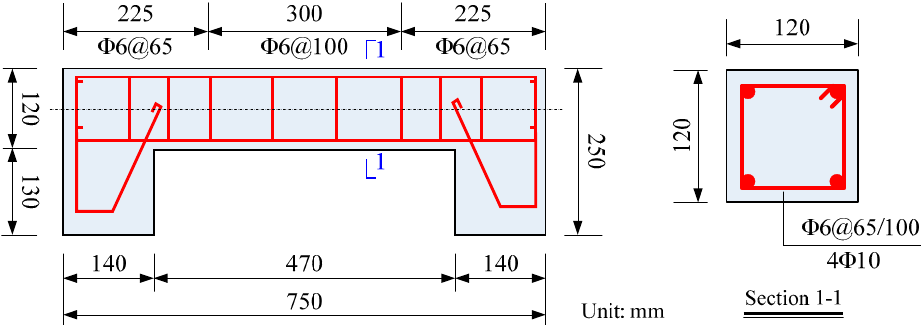
Figure 1. Configuration of the specimen (unit: mm), the thickness of concrete covers was 15 mm.